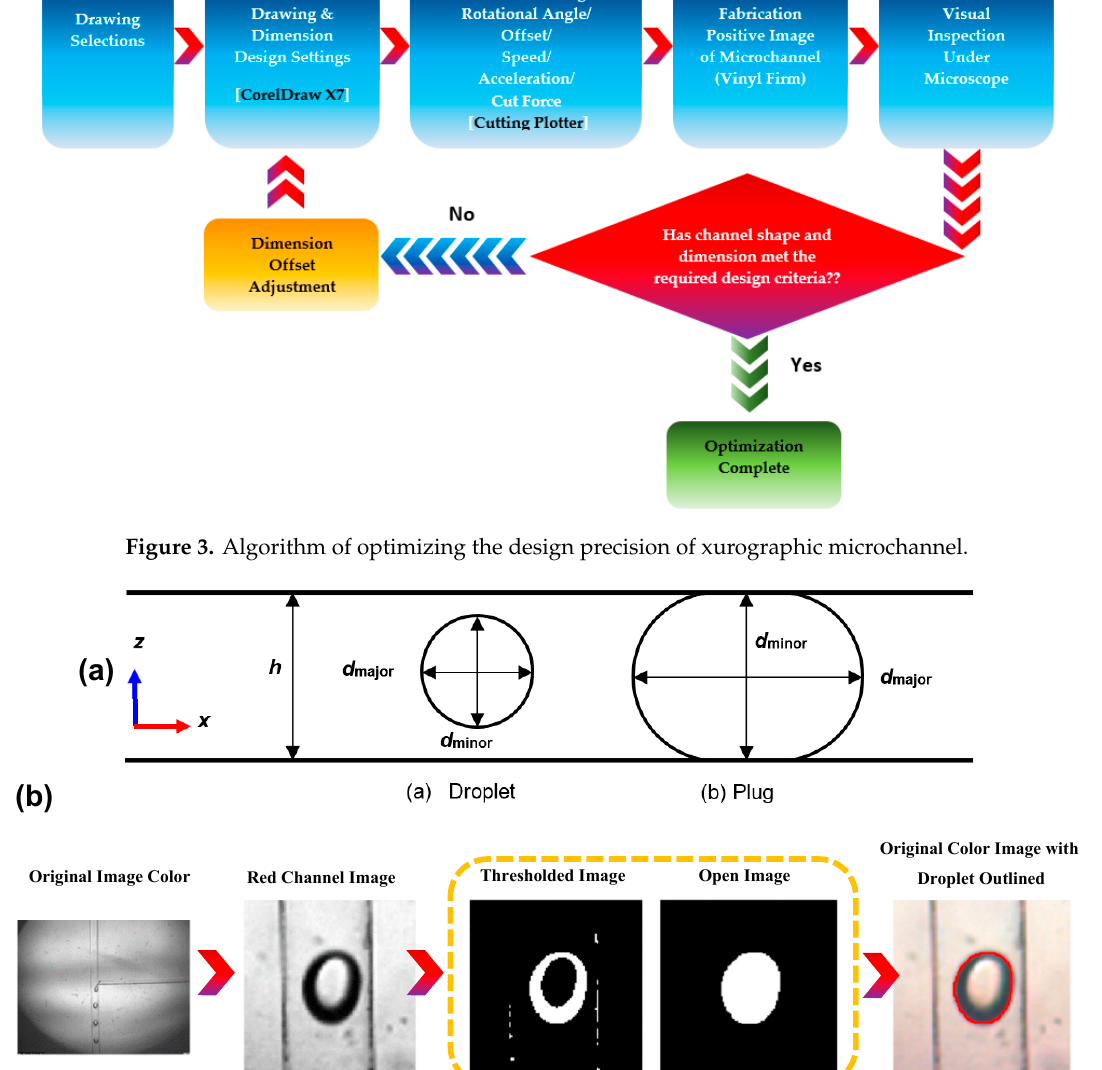
Figure 4. ( a ) Schematic diagram of the shape of confined droplets and plugs in microchannel. Major droplet diameter (d major ) denotes the longest dimension of the projected area of droplet/plug whereas the minor droplet diameter (d minor ) indicates the shortest dimension of the projected area of droplet/plug. The depth of the microchannel was denoted as h. ( b ) Image thresholding analysis of droplet or plug diameter in microchannel using MATLAB.